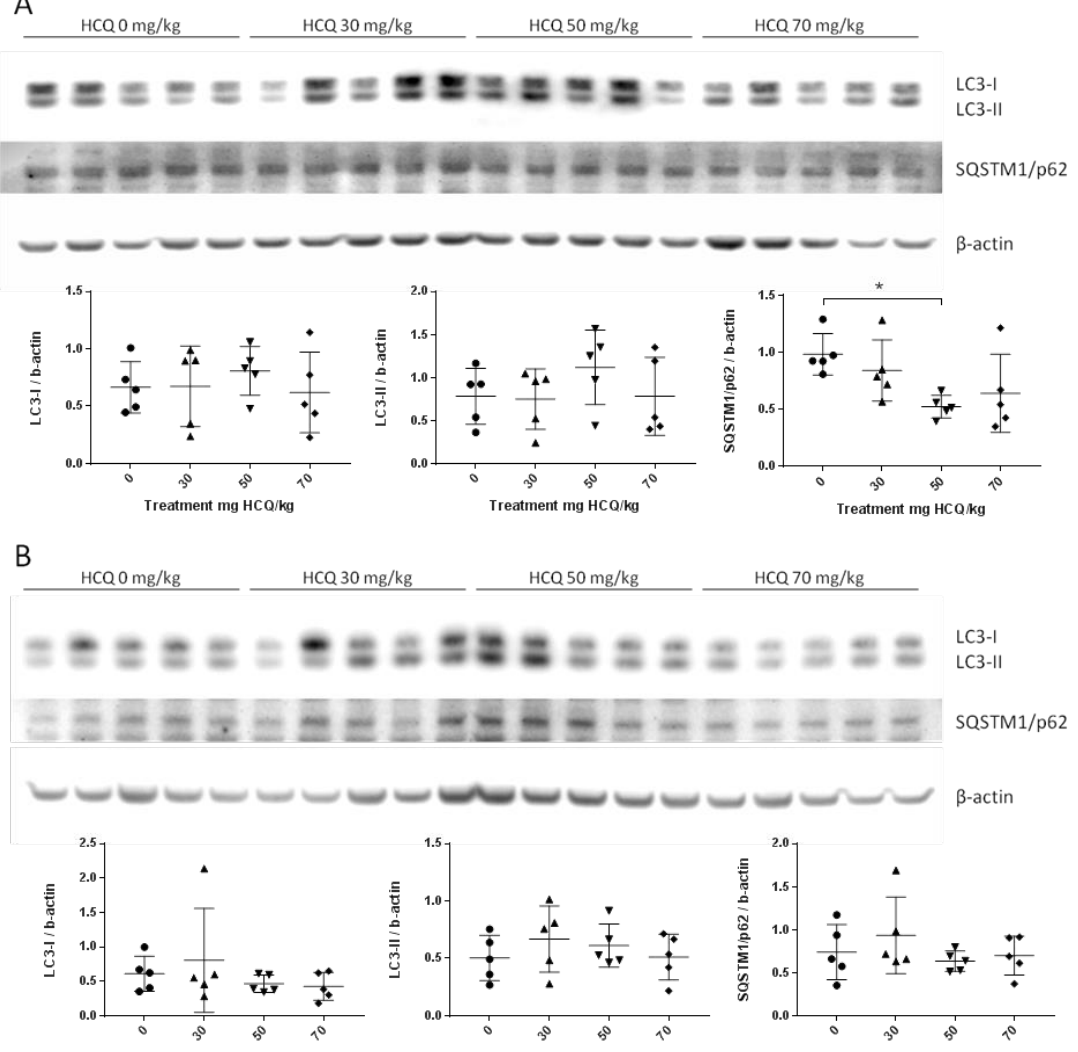
Figure 4. Representative Western blot of LC3 and SQSTM1 / p62 proteins in the anterior tibialis muscle of adult mice sacrificed at PND136 showing the inter-individual and inter-group variation of protein expression: ( A ) Male data n = 5 / group; ( B ) Female data n = 5 / group. Standardized protein levels were analysed by Kruskal–Wallis test. Mann–Whitney was used for multiple comparisons; * p < 0.05.